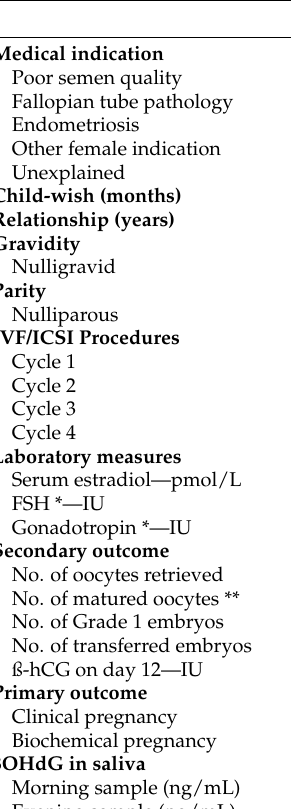
Table 2. Diagnosis and treatment history of the patients studied (N =